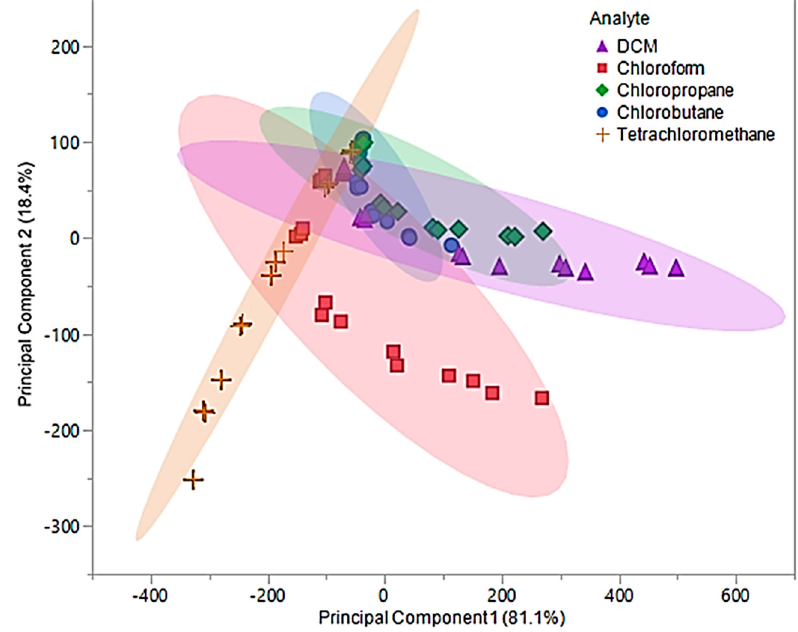
Figure 8. Principal component plot for discrimination of five chlorinated VOCs with respect to a three sensor MSA. Plot considers 75 total measurements consisting of three replicate measurements at five different flow ratios for each VOC (15 measurements per sample) using composite sensors.